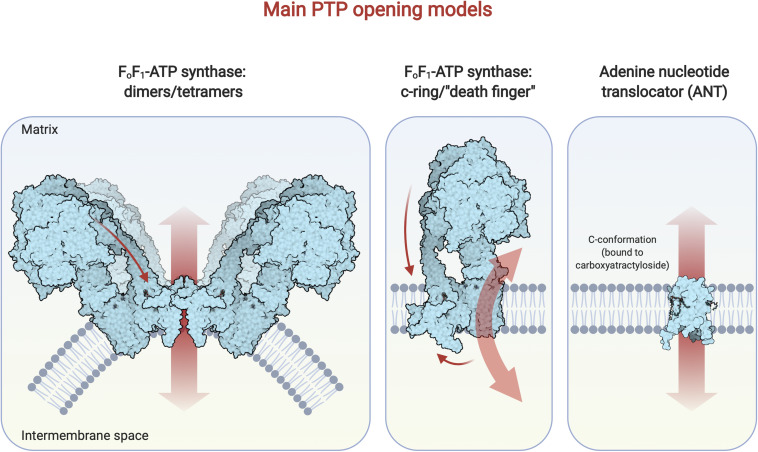
Main PTP opening models. Here the most recent and supported models for PTP opening are depicted. On the left: the FoF1-ATP synthase dimer/tetramer hypothesis postulates that the pore forms within the membrane-embedded domain, comprising the e and g subunits at the dimer/tetramer interface; a conformational change is induced by Ca2+ binding to the F1 portion of the enzyme and is transmitted (arrow) via the peripheral stalk (Giorgio et al., 2018). The diagram was drawn on the basis of a recent crystal structure (Spikes et al., 2020) of dimeric bovine F-ATP synthase. In the middle: the c-ring hypothesis proposes that the pore opens within the c-ring after the Ca2+- dependent dissociation of the F1 domain from Fo (Alavian et al., 2014). The “death finger” hypothesis (Gerle, 2016, 2020) posits that Ca2+ binding in the F1 domain determines a conformational change in the region that is transmitted along the peripheral stalk (upper arrow), leading to the displacement of subunits e and 6.8 PL in the Fo portion; this, in turn, allows the removal of the lipid plug from the c-ring leading to PTP opening. The diagram was drawn on the basis of the same crystal structure referred above (Spikes et al., 2020). On the right: the ANT hypothesis [extensively reviewed in Bround et al. (2020)] proposes that a Ca2+-dependent conformational change of the ANT leads to PTP opening. The ANT c-state diagram was adapted from a crystal structure (Nury et al., 2005) of ANT in association with its selective inhibitor, carboxyatractyloside, that has been recognized as a PTP-inducer.